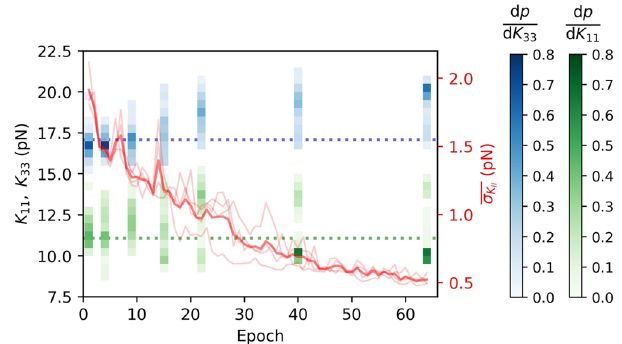
Figure 6. Possible overfitting in the extraction of elastic constants from experimental data. Note how the accuracy of the method improves with the number of epochs for numerical validation data (in red, right axis), but can lose accuracy for a high number of epochs on experimental data (for epochs (cid:31) 10 , in green and blue histograms, left axis). Dotted horizontal lines show the anticipated values of the elastic constants from the literature for E7. σ K is mean absolute error of predicted elastic constants corresponding to the numerical ii examples from the validation set; the solid line represents the average that generally decreases from epoch to epoch. The probability density functions of predictions d p / d K 11 and d p / d K 33 after 1, 4, 9, 15, 22, 40, 64 epochs are shown. Bin width is 0.5 pN.